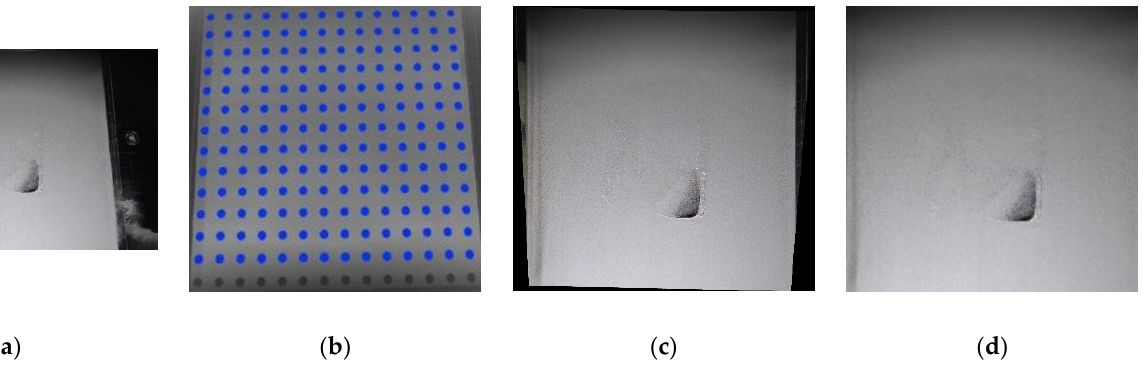
Figure 1. Camera calibration, ( a ) original image, ( b ) checkerboard for calibration, ( c ) image fetch from calibrated camera, ( d ) image after perspective transformation.